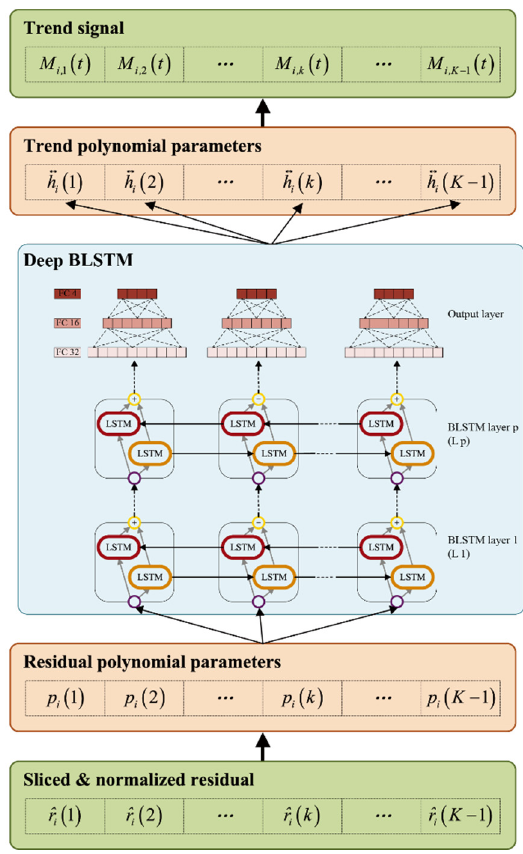
Figure 3. BLSTM-based sifting algorithm.